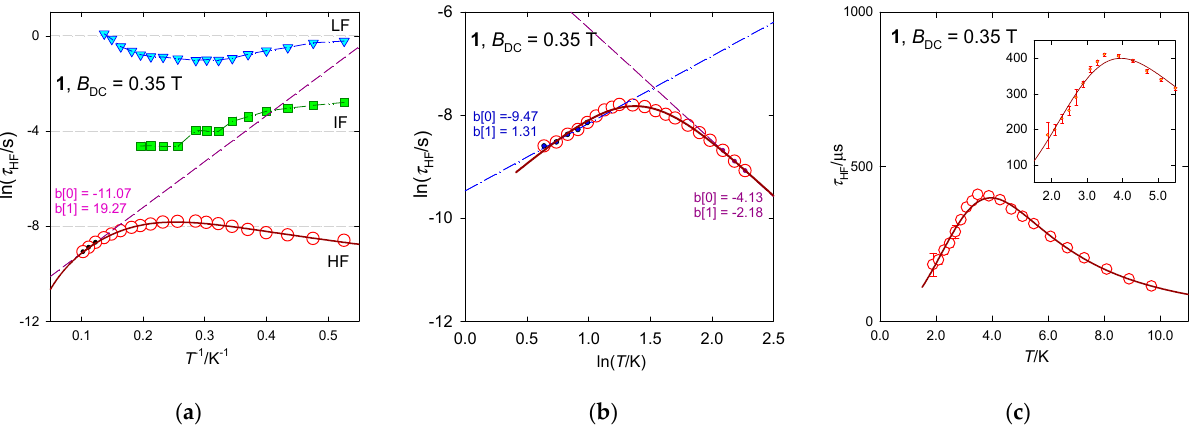
Figure 8. Various dependences of the high-frequency relaxation time in [Mn( bzpy ) 4 Cl 2 ]. Full line—fitted over the whole temperature range with τ − 1 = GT l + FT − k . ( a ) Arrhenius-like plot, ( b ) log-log plot, ( c ) relaxation time vs temperature. The standard deviations for each data point are displayed in the inset of panel ( c ). Data adapted from ref. [52]. 2019, American Chemical Society.